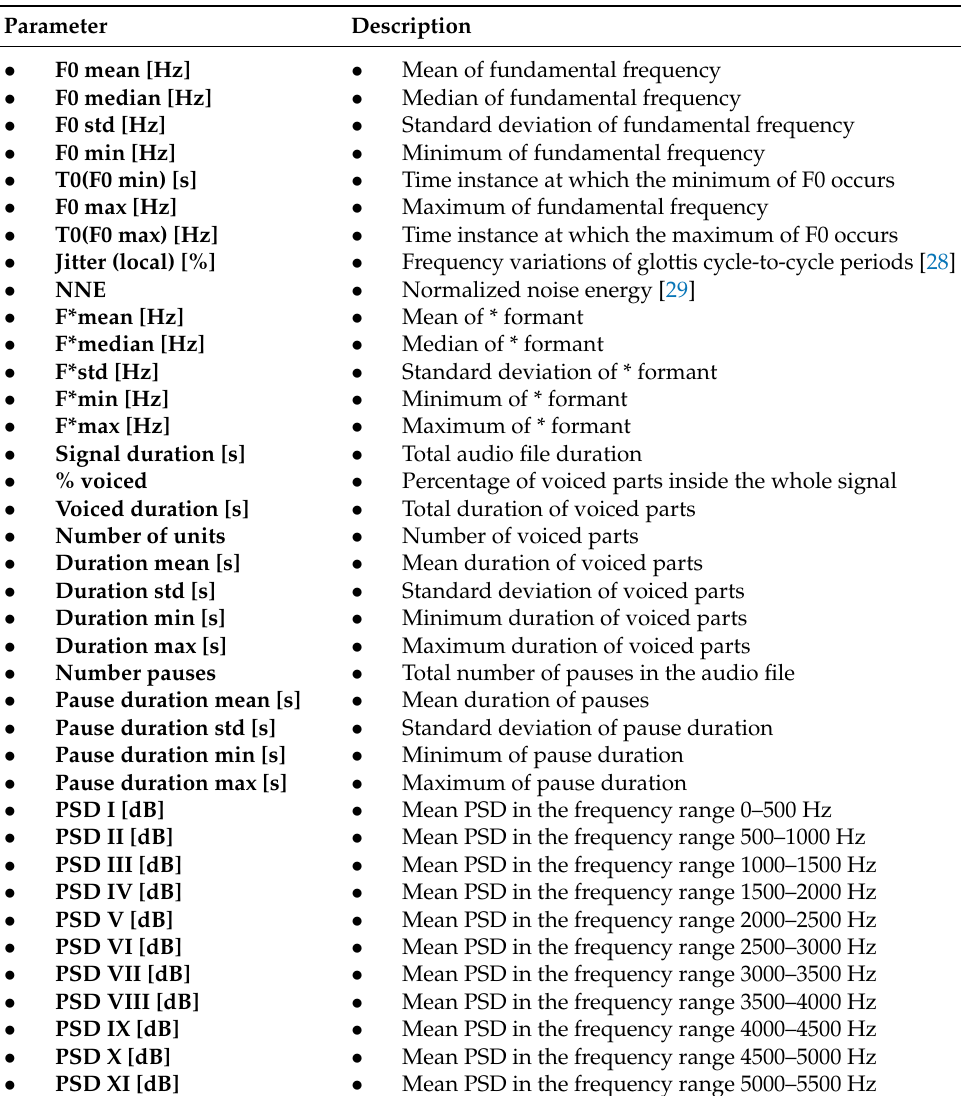
Table 1. Acoustical analysis of /a’jw O e/: BioVoice parameters. Parameter